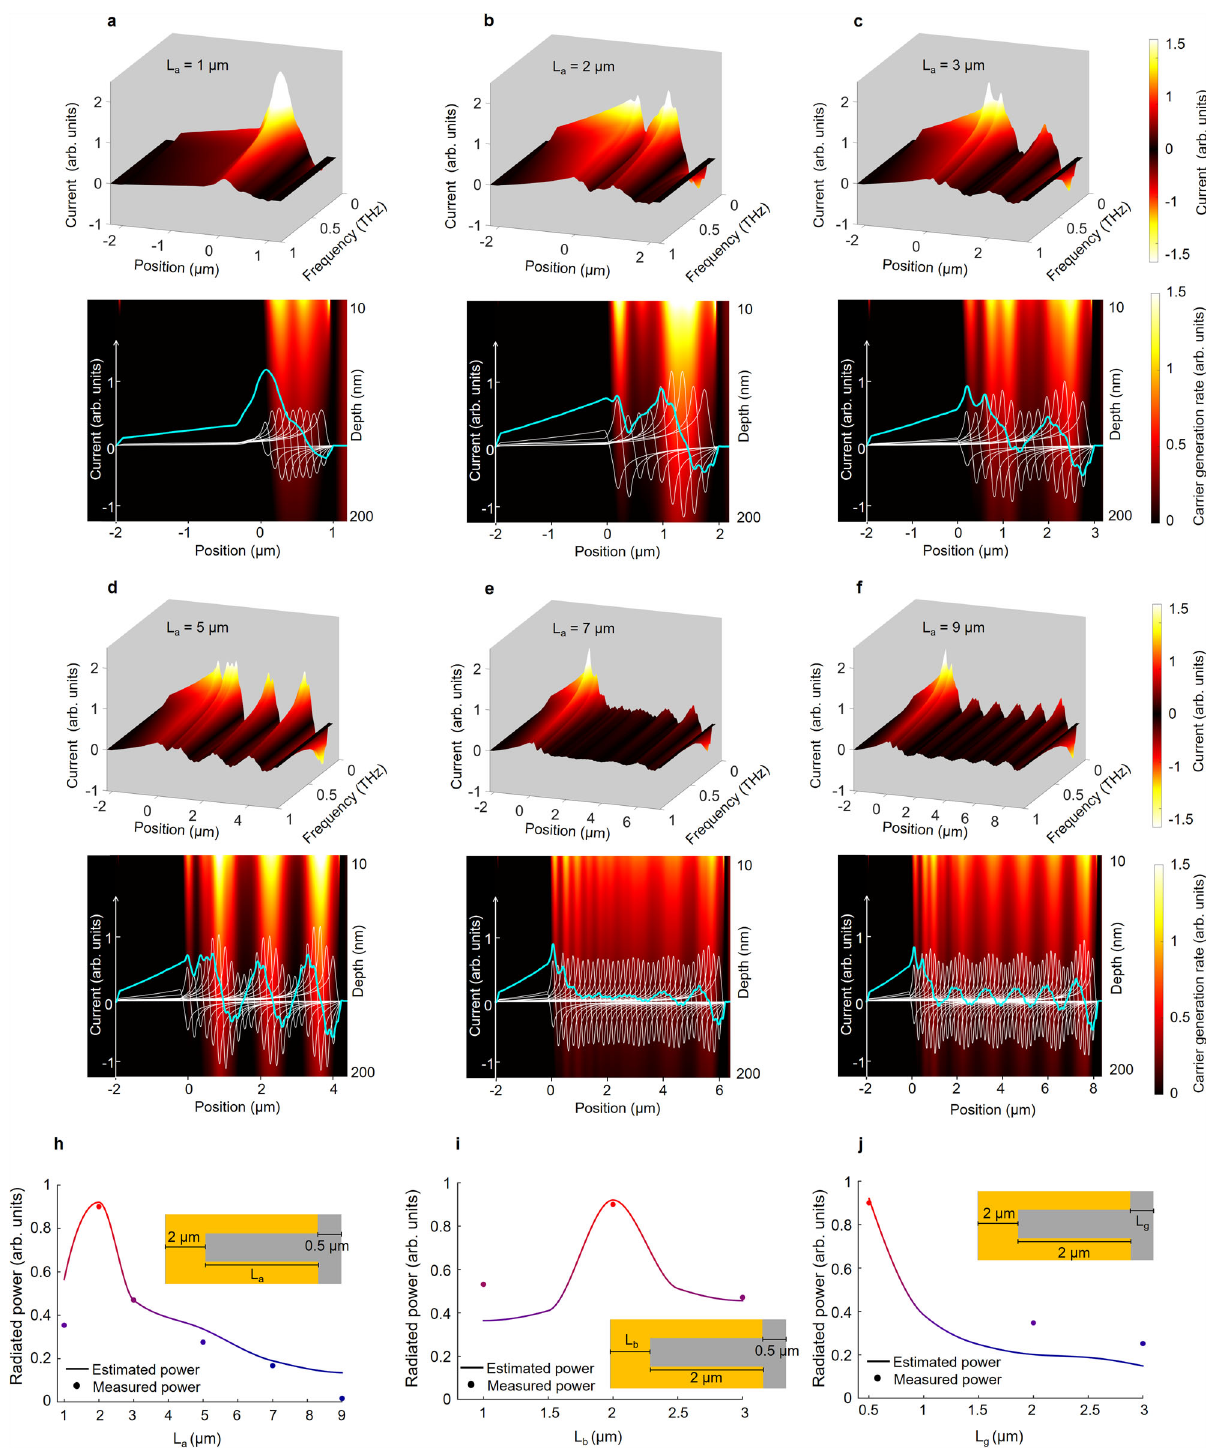
Fig. 4 Impact of the nanoantenna geometry on the wavelength conversion ef fi ciency. a – f Top: The induced current on the nanoantennas as a function of frequency when the nanoantenna length ( L a ) is varied from 1 to 9 μ m. The ground line width ( L b ) and the gap between the nanoantenna array rows ( L g ) are chosen as 2 and 0.5 μ m. The ground line is located between − 2 μ m and 0 positions and the nanoantenna is located between 0 and 1 – 9 μ m positions along the z-axis. a – f Bottom: Decomposition of the total induced current on the nanoantennas (teal lines) to the individual contributions of the injected currents from different positions of the nanoantennas (white lines) at 0.2 THz. The background color maps show the electron generation pro fi les averaged over the nanoantenna width. Predicted and measured terahertz radiation power from fabricated nanoantenna arrays with different nanoantenna lengths, ground line widths, and gap sizes between the nanoantenna rows are shown in h , i , and j respectively. All the fabricated nanoantenna arrays have a 1 × 1 mm 2 area and are characterized using the same optical pulses with 120 fs pulse width, 2.63 nJ pulse energy, and 76 MHz repetition